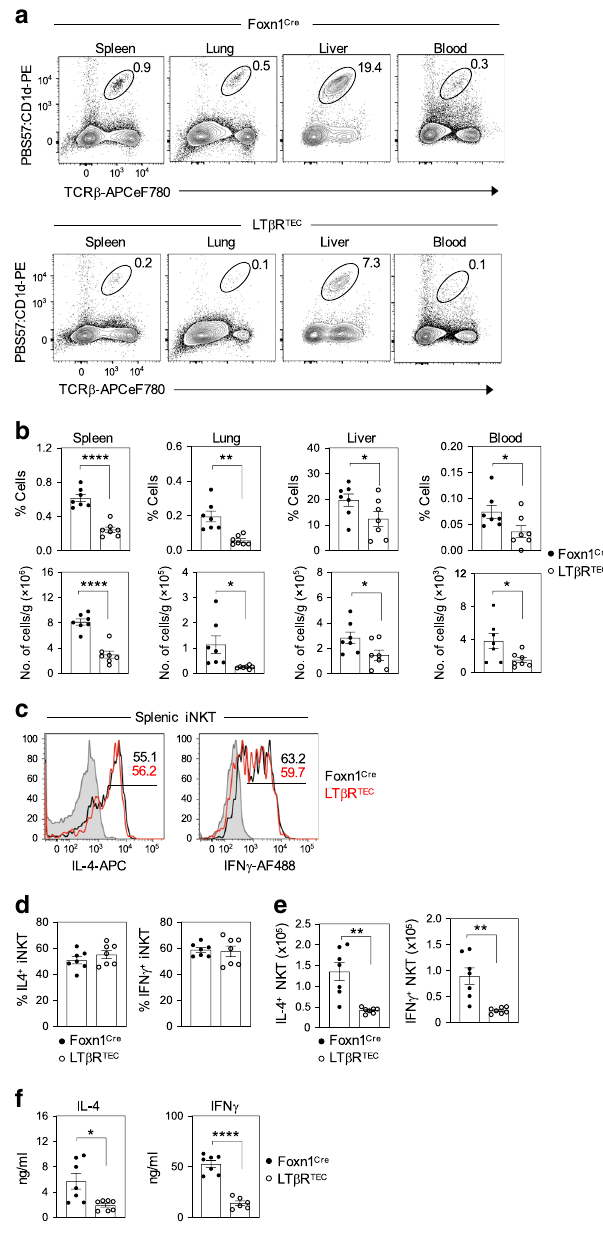
Fig. 8 LT β R expression by thymic epithelium determines peripheral iNKT-pool size. a indicated that tissues from control Foxn1 Cre and LT β R TEC mice were analysed for iNKT cell frequencies by fl ow cytometry. Graphs in b show cell percentages and number of iNKT cells per gram or ml of tissue, as indicated, in Foxn1 Cre ( n = 7 biologically independent samples, closed symbols) and LT β R TEC ( n = 7 biologically independent samples, open symbols), over three independent experiments. Signi fi cant P values using two-tailed unpaired t test are as follows: % spleen P ≤ 0.0001, % lung P = 0.0012, % liver P = 0.0494, % blood P = 0.0383, no. of cells in the spleen P ≤ 0.0001, no. of cells in the lung P = 0.0255, no. cells in the liver P = 0.0459, no. of cells in blood P = 0.0371. c Flow cytometric analysis of intracellular IL-4 or IFN γ expression in splenic iNKT cells in Foxn1 Cre (black lines) and LT β R TEC (red lines) mice, 2 h after i.v. administration of α Gal-Cer. Grey histograms show levels of staining in non-injected mice. Percentages ( d ) and numbers ( e ) of IL-4 + and IFN γ + splenic iNKT after α Gal-Cer stimulation of Foxn1 Cre ( n = 7 biologically independent samples, closed symbols) and LT β R TEC mice ( n = 8 biologically independent samples, open symbols), over three independent experiments. Signi fi cant P values using two-tailed unpaired t test as follows: no. of IL-4 + cells P = 0.0011, no. of IFN γ + cells P = 0.0014. f shows ELISA quantitation of IL-4 (2 h post Gal- Cer injection) Foxn1 Cre ( n = 7 biologically independent samples, closed symbols) and LT β R TEC mice ( n = 7 biologically independent samples, open symbols), and IFN γ (16 h post Gal-Cer injection) in serum samples of Foxn1 Cre ( n = 7 biologically independent samples, closed symbols) and LT β R TEC mice ( n = 6 biologically independent samples, open symbols), over three independent experiments. Signi fi cant P values using two-tailed unpaired t test are as follows: IL-4 P = 0.0117, IFN γ P ≤ 0.0001. All data are represented as mean ± SEM. * P < 0.05, ** P < 0.01, and **** P < 0.0001. Source data are provided as a Source Data fi